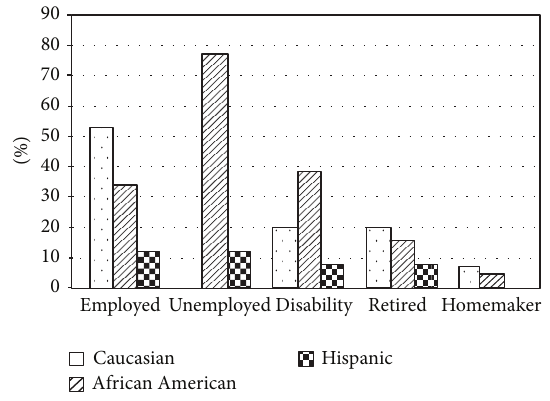
Figure 3: In regard to employment status, there was a significant difference between the 3 racial/ethnic groups ( 𝑃 = 0.03 ). Group by group comparison: Caucasian versus African American: 𝑃 = 0.47 ; Caucasian versus Hispanic: 𝑃 = 0.02 ; African American versus Hispanic: 𝑃 = 0.1